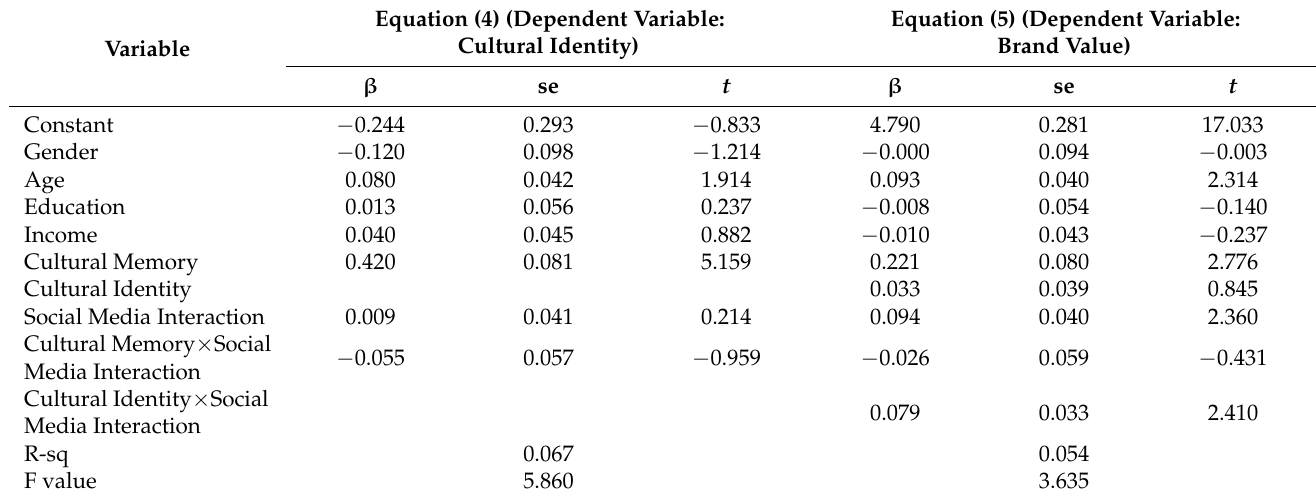
Table 9. Moderated mediation model test.